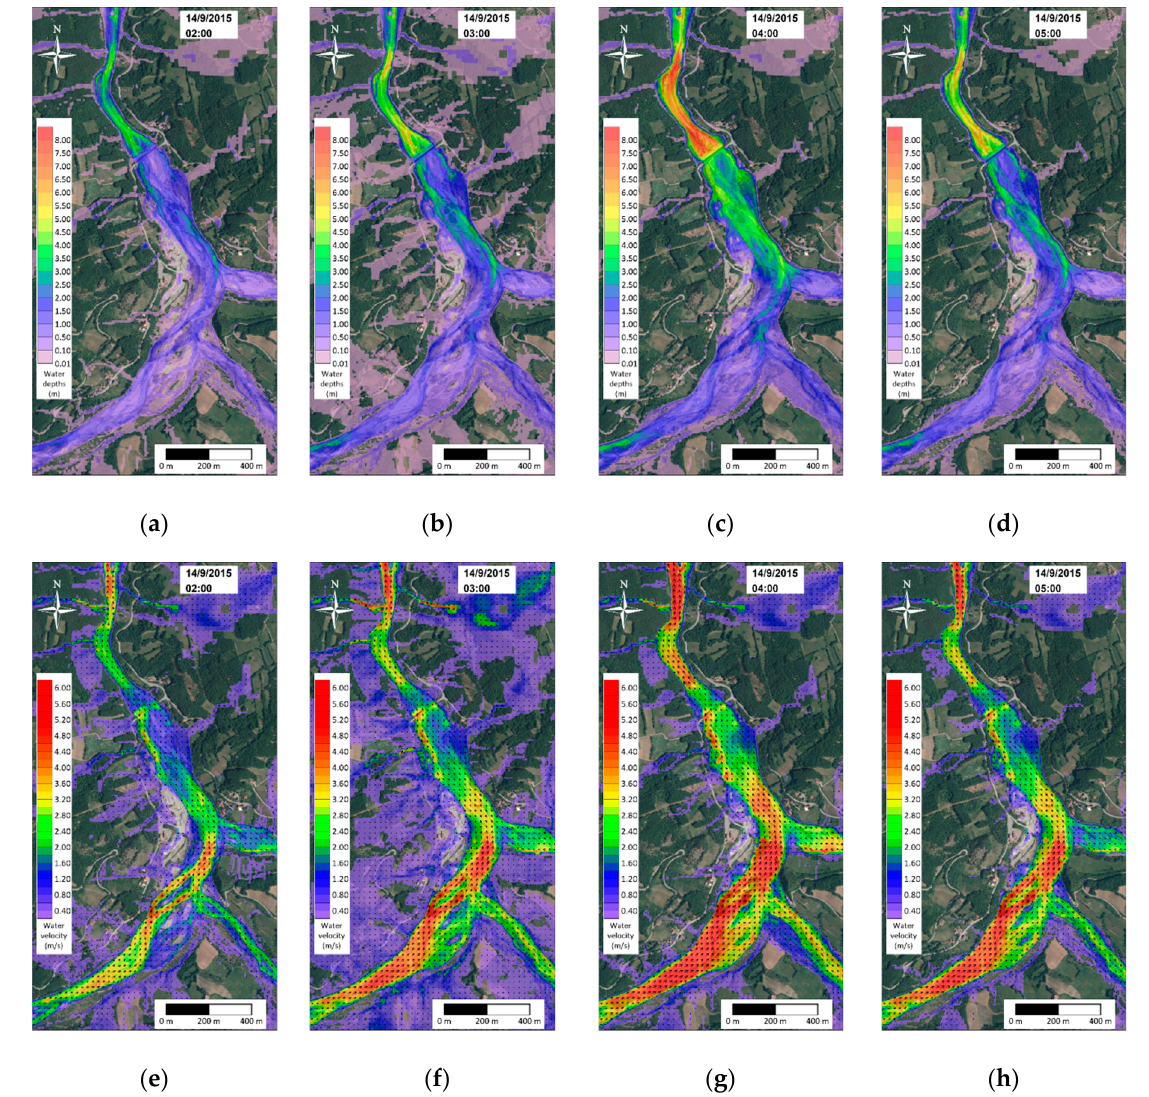
Figure 21. Detail of the water depth ( a–d ) and velocity fields ( e – h ) at the confluence of two right tributaries of the Nure from 02:00 UTC + 1 to 05:00 UTC + 1 on 14 September 2015: ( a , e ) 02:00 UTC + 1; ( b , f ) 03:00 UTC + 1; ( c , g ) 04:00 UTC + 1 and ( d , h ) 05:00 UTC + 1. (Velocity vectors are plotted only one every five for the sake of graphical representation).